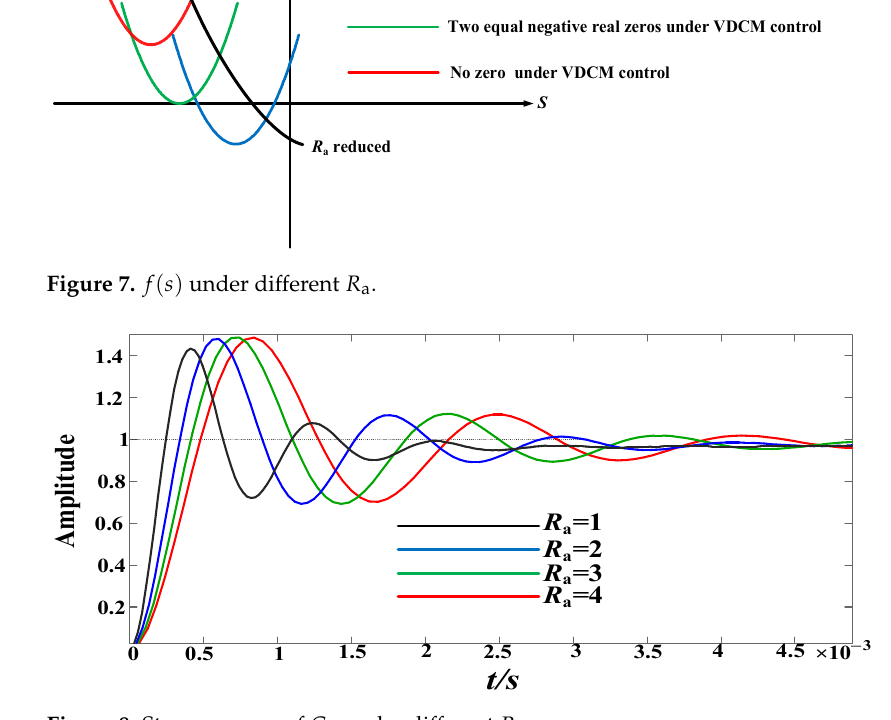
Figure 8. Step response of G u under different R a .